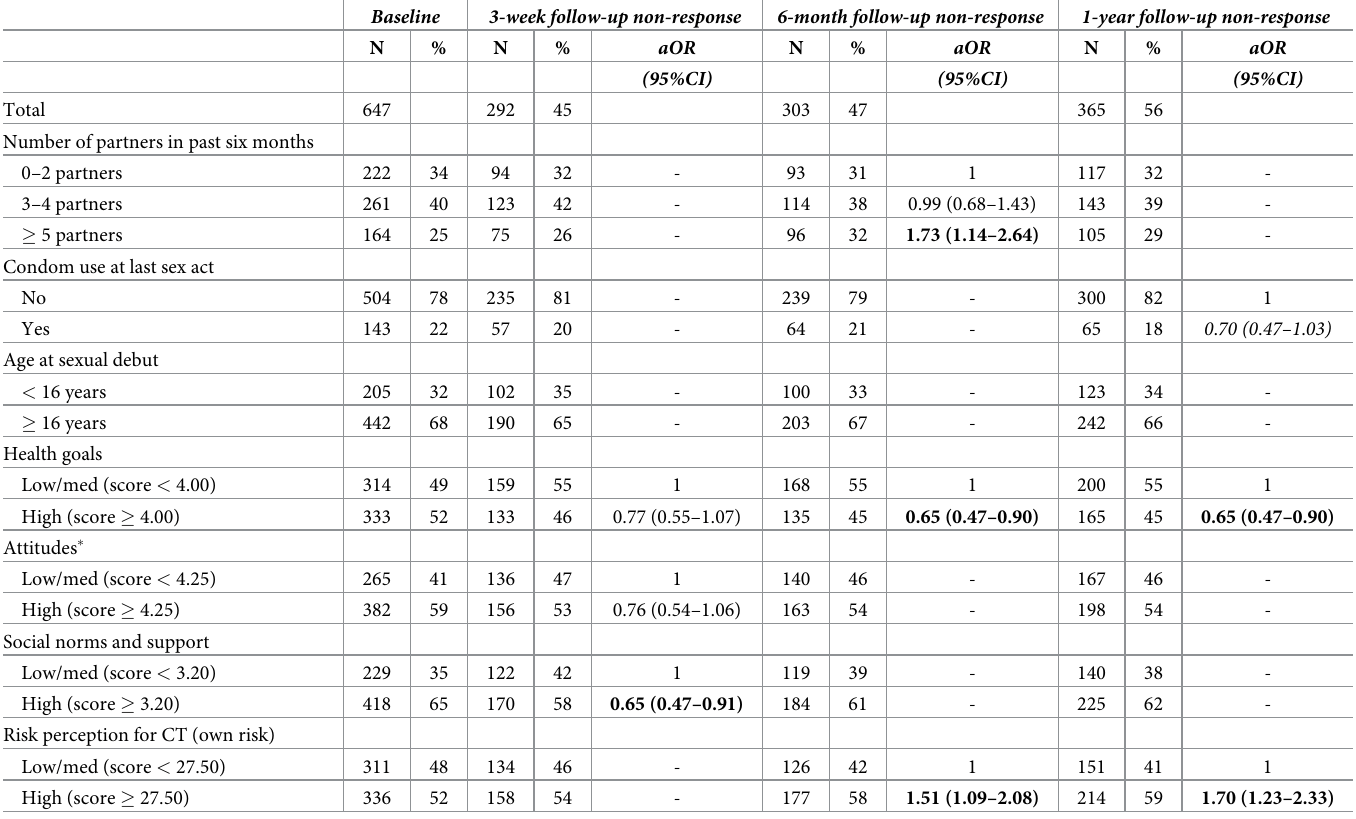
Table 2. Multivariable logistic regression analyses of predictors of non-response at the three follow-up data collection moments for participants who visited the STI clinic in